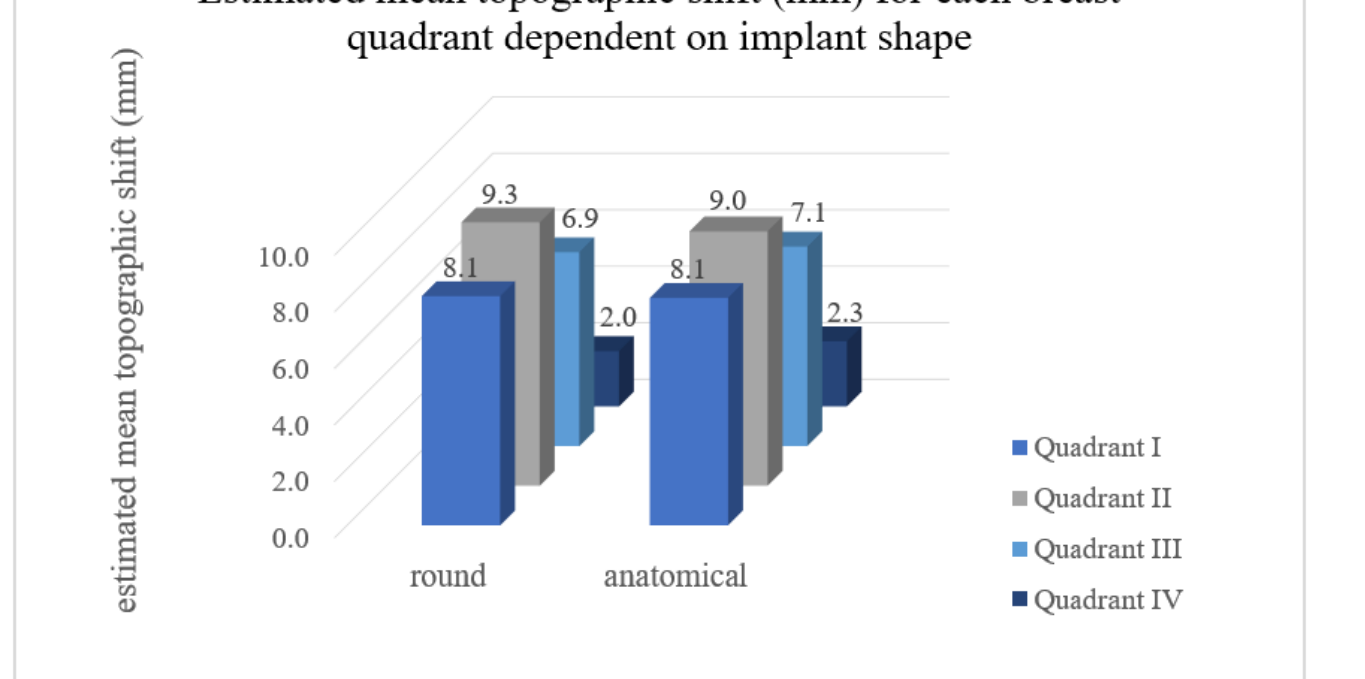
Figure 5. Estimated mean TS for each breast quadrant dependent on implant shape. Quadrant I = superolateral, quadrant II = superomedial, quadrant III = inferomedial and quadrant IV = inferolateral breast quadrant. No significant difference was observed between the shapes “round” and “anatomic” concerning TS in all quadrants.